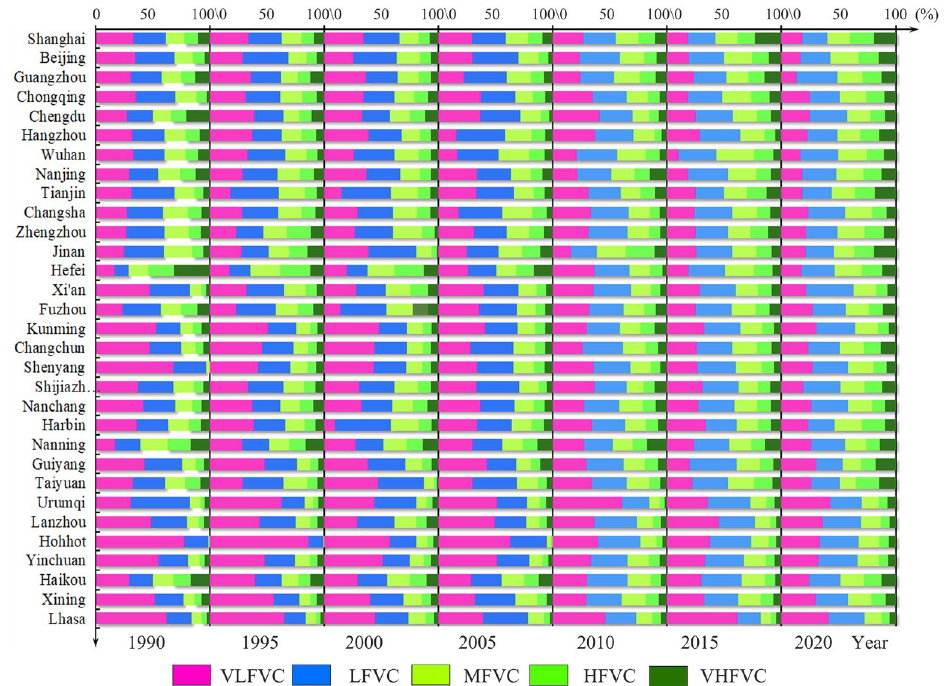
Figure 8. Percentage accumulation FVC of different grades in provincial capital cities from 1990 to 2020.